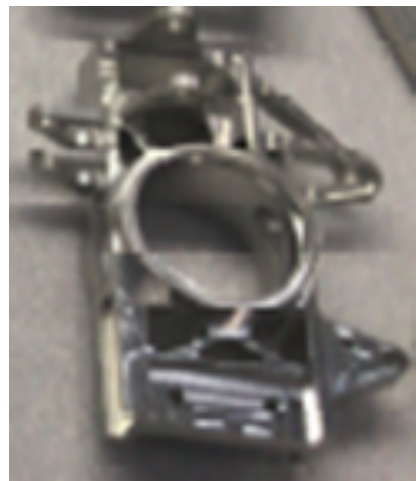
Figure 22. Tested vehicle.